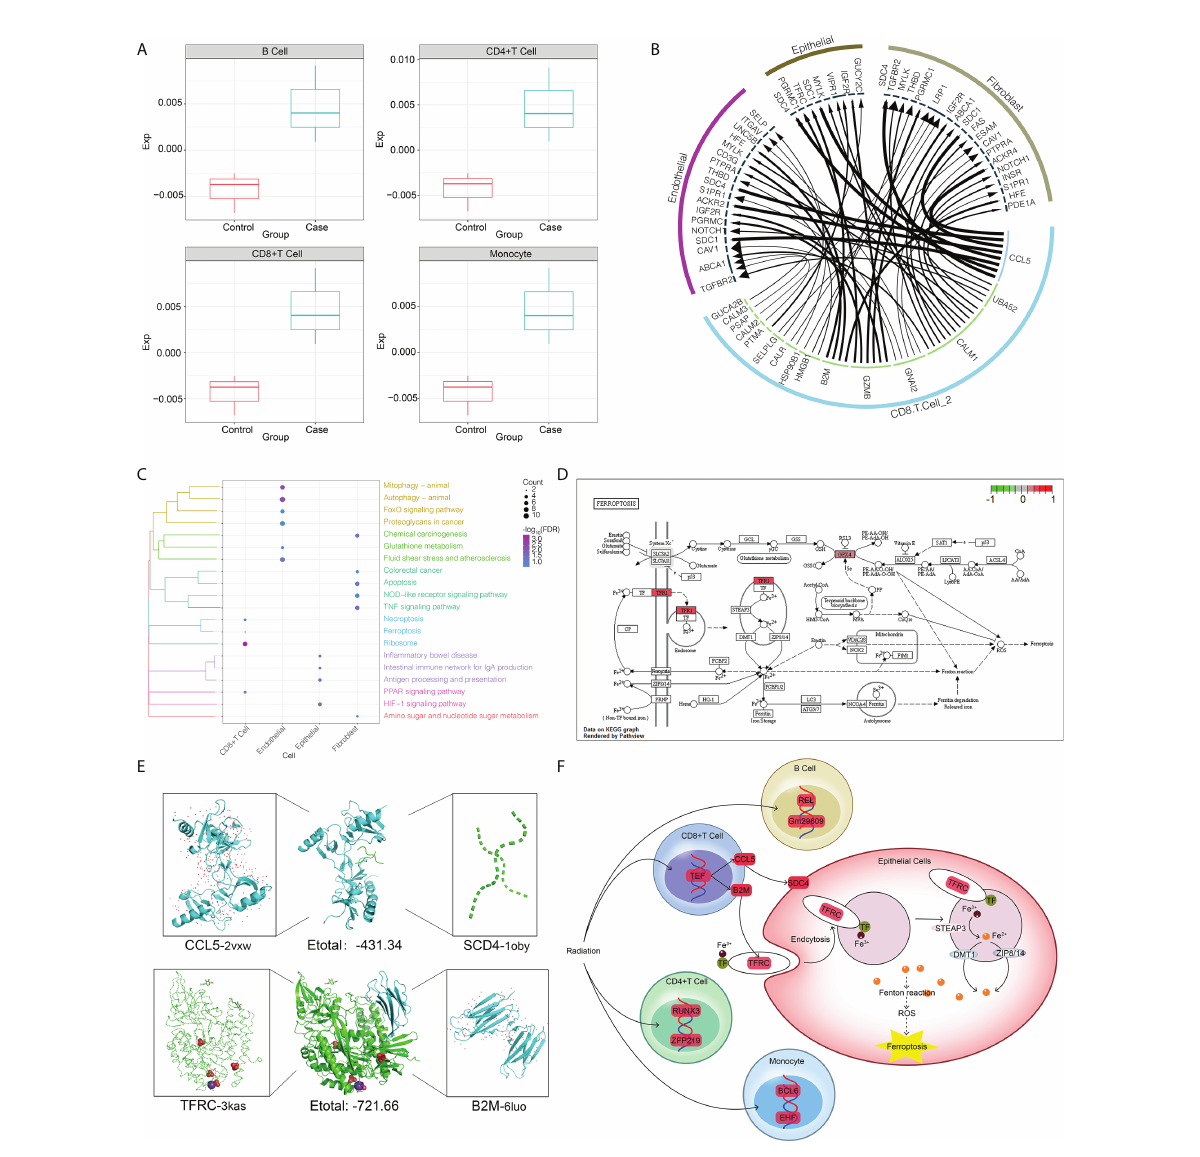
FIGURE 5 RT-induced intercellular communication of microenvironmental immune cells in intestinal tissues. (A) The abundance of radiation-speci fi c immune cells was signi fi cantly higher than that of the control group. (B) The interaction of radiation-speci fi c CD8+T cells with endothelial cells, epithelial cells, and fi broblasts. The outermost circle is the cell type, and the inner circle is the surface receptor of the cell. (C) Genes regulated by radiation-speci fi c immune cells CD8+ T cells activate the iron death pathway in epithelial cells. Where red represents upregulation of gene expression. (D) Pathways signi fi cantly enriched in endothelial cells, epithelial cells and fi broblasts after radiation. The clustering tree of the pathway is shown on the left. The size of the bubble represents the number of genes involved in the pathway, and the color of the bubble represents the P value of the pathway. (E) Three-dimensional structures showing molecular docking of B2M with CCL5 or TFRC. (F) Mechanisms by which radiation-speci fi c immune cells CD8+ T cells regulate gene expression in epithelial cells through the CCL5-SCD4 axis and B2M-TFRC to promote iron death in epithelial